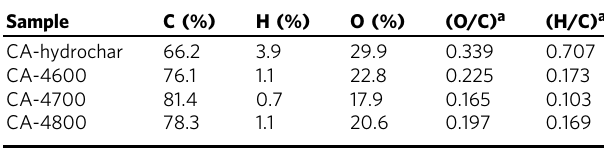
Table 1 Elemental analysis of cellulose acetate-derived CA- hydrochar and activated carbons derived from the